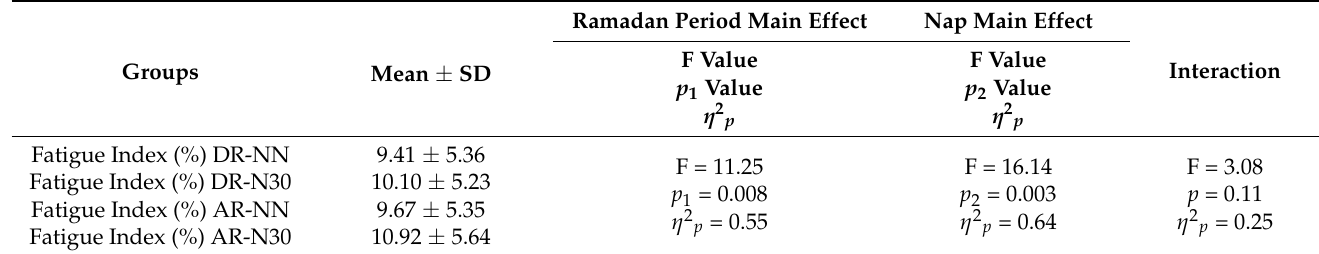
Table 4. Comparison of the measured values of the Fatigue Index (%) (n =